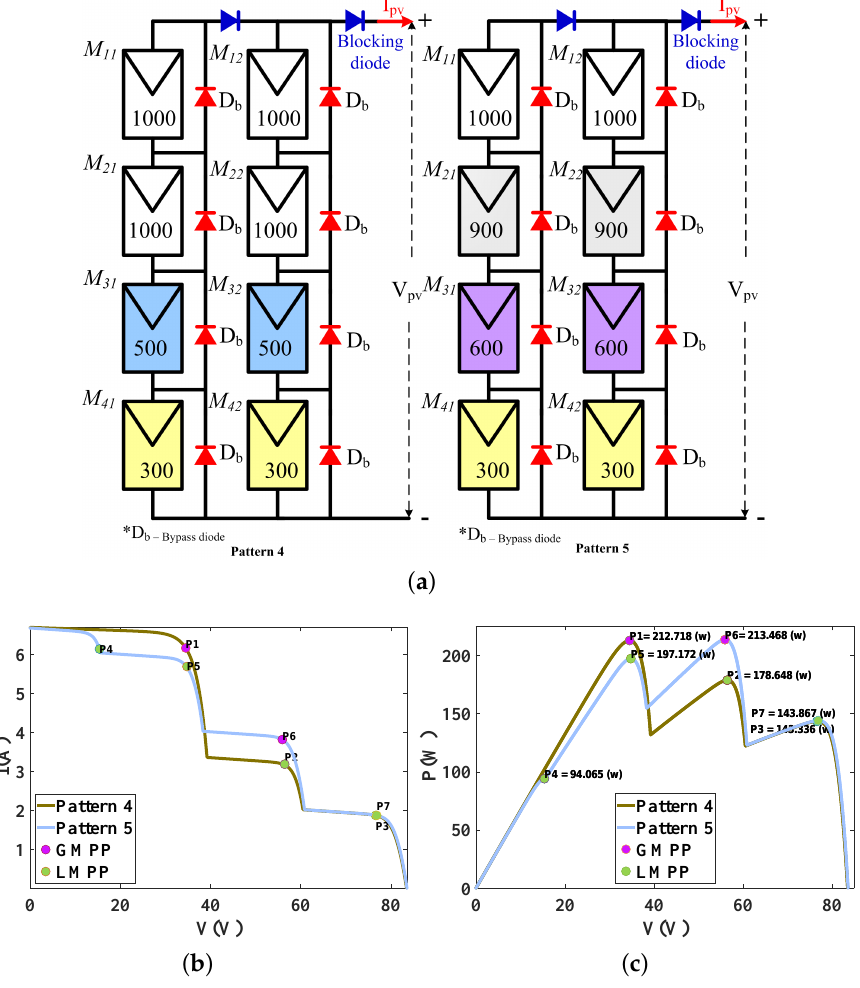
Figure 4. Partial shading analysis on SM55 PV module ( a ) Shading patterns patterns, ( b ) I-V curves and ( c ) P-V